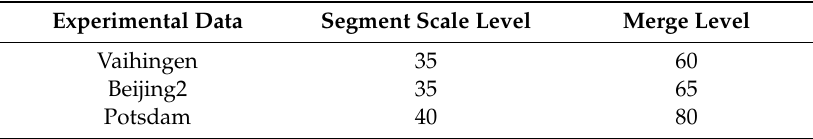
Table 1. Related parameters in image segmentation